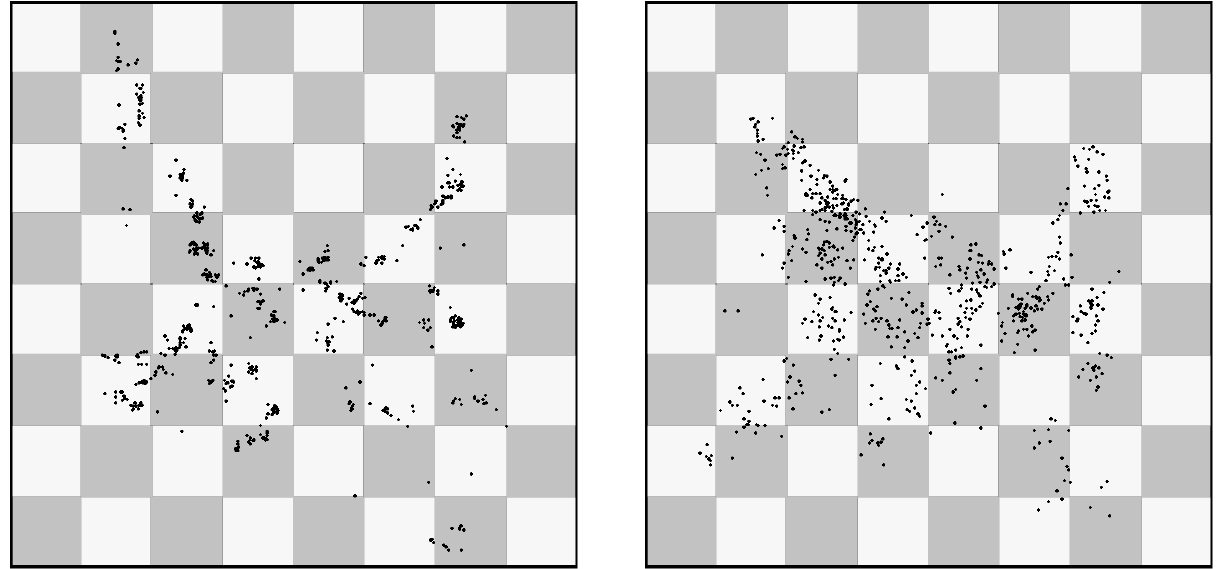
Figure 1. (a) Points of regard of a participant with stable eye gaze (left) and (b) a participant with a large amount of fixational eye movement